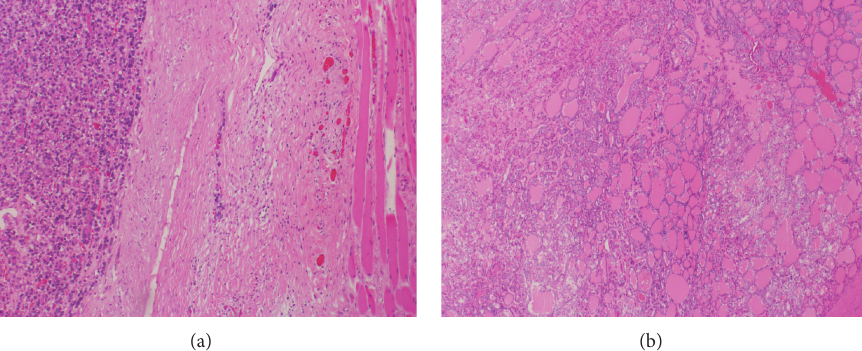
Figure 2: (a) Infiltrating clusters of papillary tumor cells in the skeletal muscle ( H&E ×100) and (b) the follicular tumor cells ( H&E ×200)